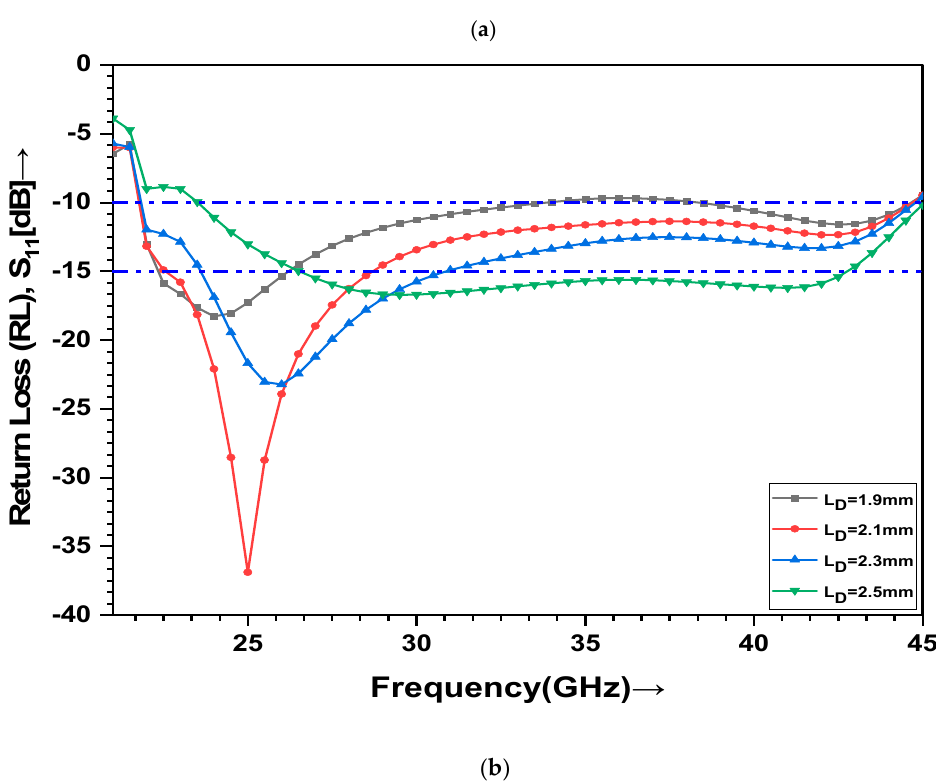
21 (dB), ( b ) return loss, S 11